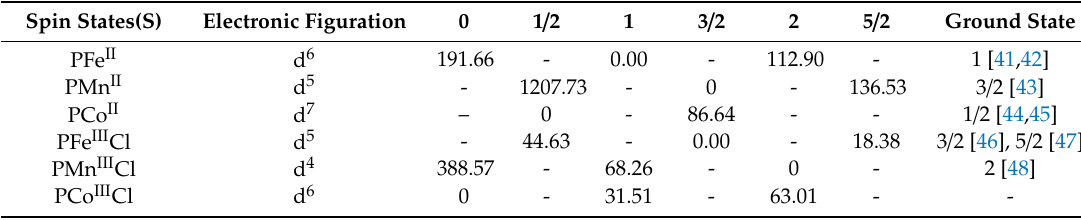
Table 1. Energies (in kcal.mol − 1 ) of PM II and PM III Cl (M = Fe, Mn, and